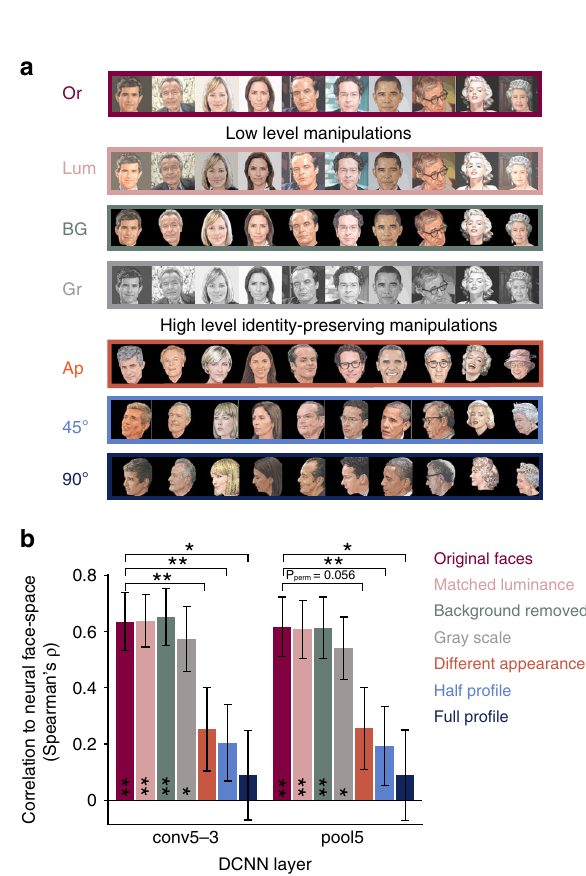
Fig. 3 The impact of low- and high-level manipulations on the DCNN to neural face-space match. a Manipulated face exemplars included in set 1, from top to bottom: Or - original face images, Lum - matched luminance, BG - removed background, Gr - gray scale conversion, Ap - different appearance of the same identities which differ in pictorial aspects such as facial expression and haircut, 45° and 90° - different images of the same identities, rotated at ~45° and ~90° view-points, respectively. b The impact of feeding the manipulated images presented in panel a to the DCNN on its correlation to neural distances in layers that originally showed a signi fi cant correlation in set 1 (layers conv5 – 3 and pool5). Error bars denote bootstrap s.e.m. on image pairs. Whereas low-level manipulations did not impact the correlation to neural data, higher level yet identity-preserving manipulations signi fi cantly reduced the correlation to chance. P values were de fi ned as the proportion of correlations delta for shuf fl ed image labels (1000 permutations) that exceeded the delta obtained from correctly labeled